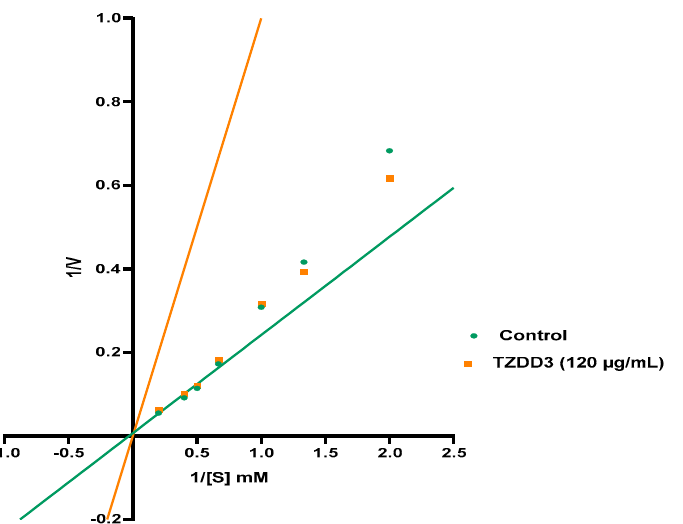
Figure 2. The inhibition of α -glucosidase activity by TZD-derivatives (10, 20, 30, 40, and 50 µg/mL). The results are represented in a clustered column. Data are presented as mean ± standard deviation values. The error bars correspond to the standard errors of the means, and asterisks (*) indicate a significant statistical difference relative to the control experiment ( p value ≤ 0.05). The arrow from the right pointing at the baseline at 0.0 represents the negative control, which is defined to have zero percent inhibition for the purpose of data normalization.